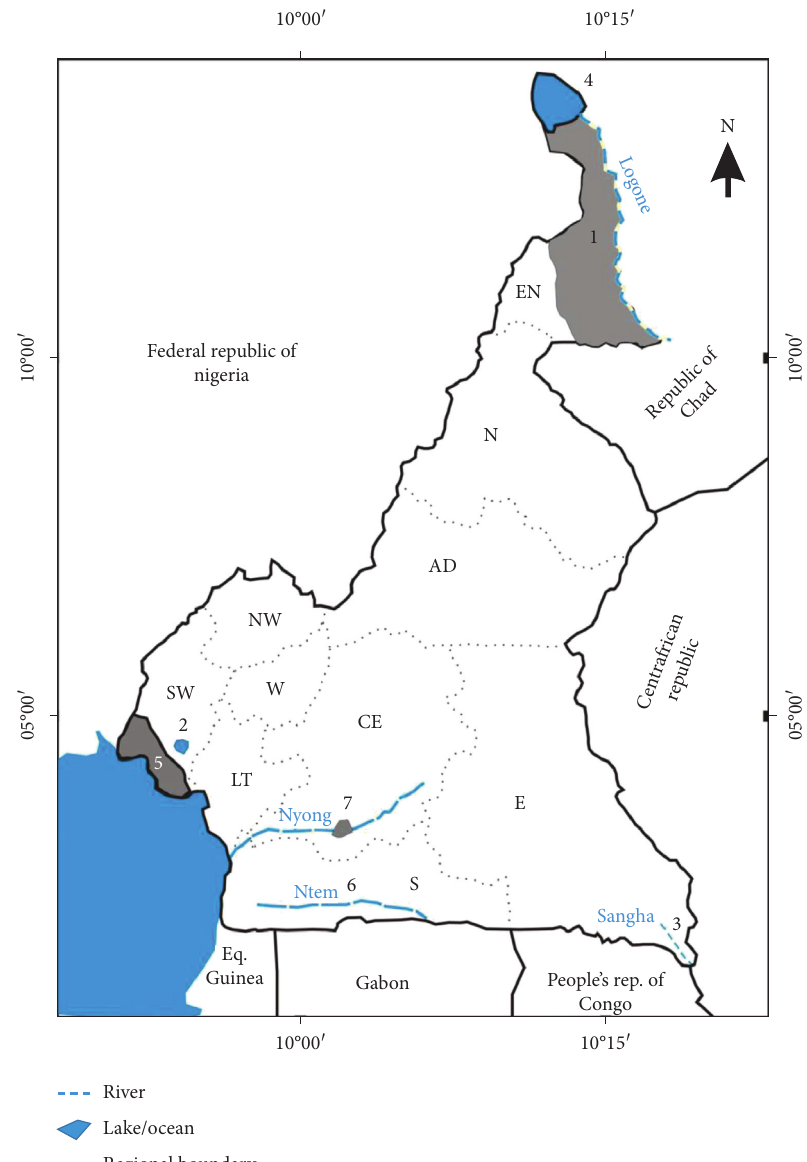
Figure 1: Location of the Ramsar sites in Cameroon [15]. Sites are numbered from youngest to oldest based designation date. (1) Waza- Logone floodplain; (2) Barombi-Mbo Lake; (3) Cameroon section of the Sangha River; (4) Cameroon section of Lake Chad; (5) Rio Del Rey Estuary; (6) Cameroon section of the Ntem River; (7) Ebogo Humid Zone; EN: Extreme North Region; NW: Northwest Region; N: North Region; AD: Adamawa Region; CE: Centre Region; E: East Region; LT: Littoral Region; S: South Region; SW: Southwest Region; W: West